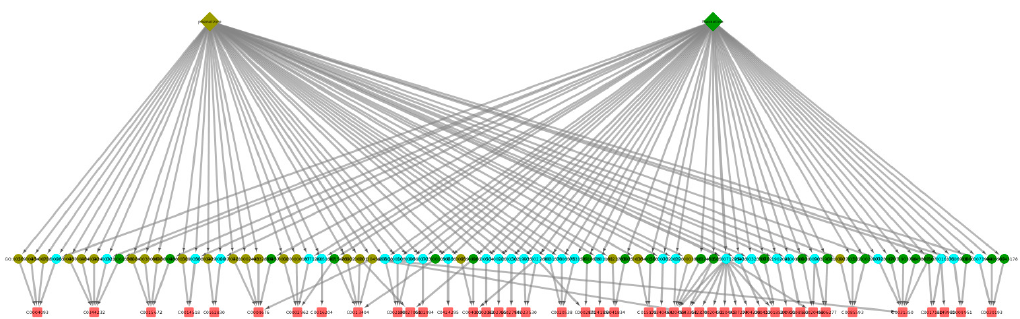
Figure 8. Fluoxetine–phenelzine drug combination network cADR space. This is a visualization of the subgraph containing the cADRs and associated GO terms for the phenelzine and fluoxetine combination. The cADRs are represented as red squares. The two drugs are represented by a light brown and a dark green diamond, respectively. GO terms associated exclusively with phenelzine are represented as light brown circles, and those exclusively associated with fluoxetine as dark green circles, whereas GO terms associated with both drugs are colored blue.